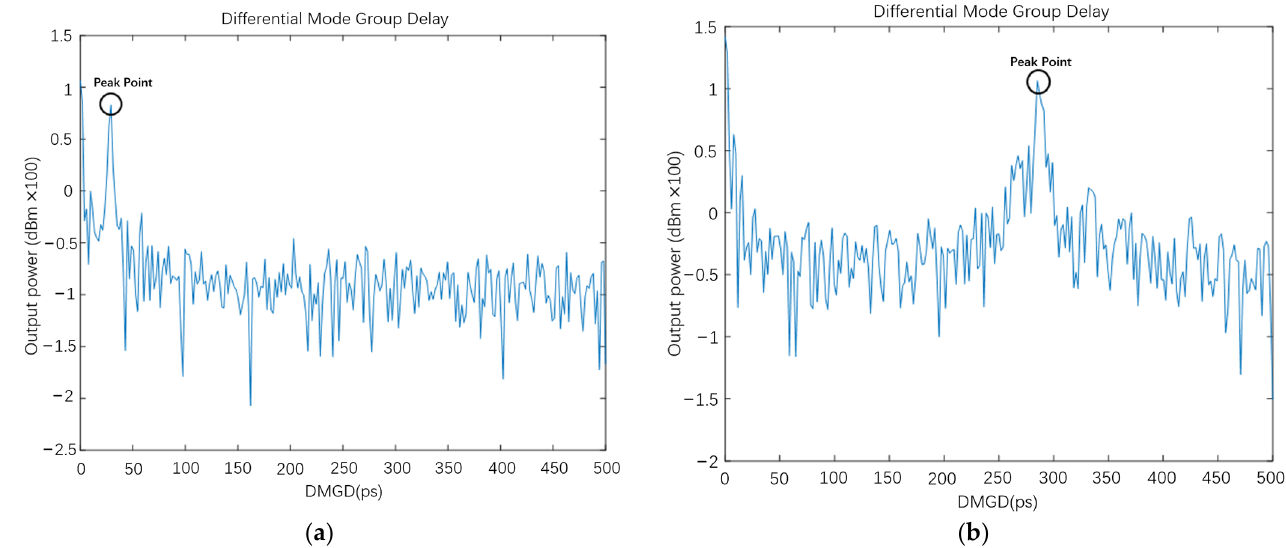
Figure 8. ( a ) The DMGD curve of 10 m TMF; ( b ) the DMGD curve of 100 m TMF. The DMGD values of the peak points in Figure 8a,b represent mode dispersion between the FM and HOM and between different HOMs of the FUT. In this experiment, only one peak point represents the mode dispersion between the FM and HOMs because utilized FUT is a TMF. From the peak points shown in Figure 8a,b, the DMGD of our TMF under